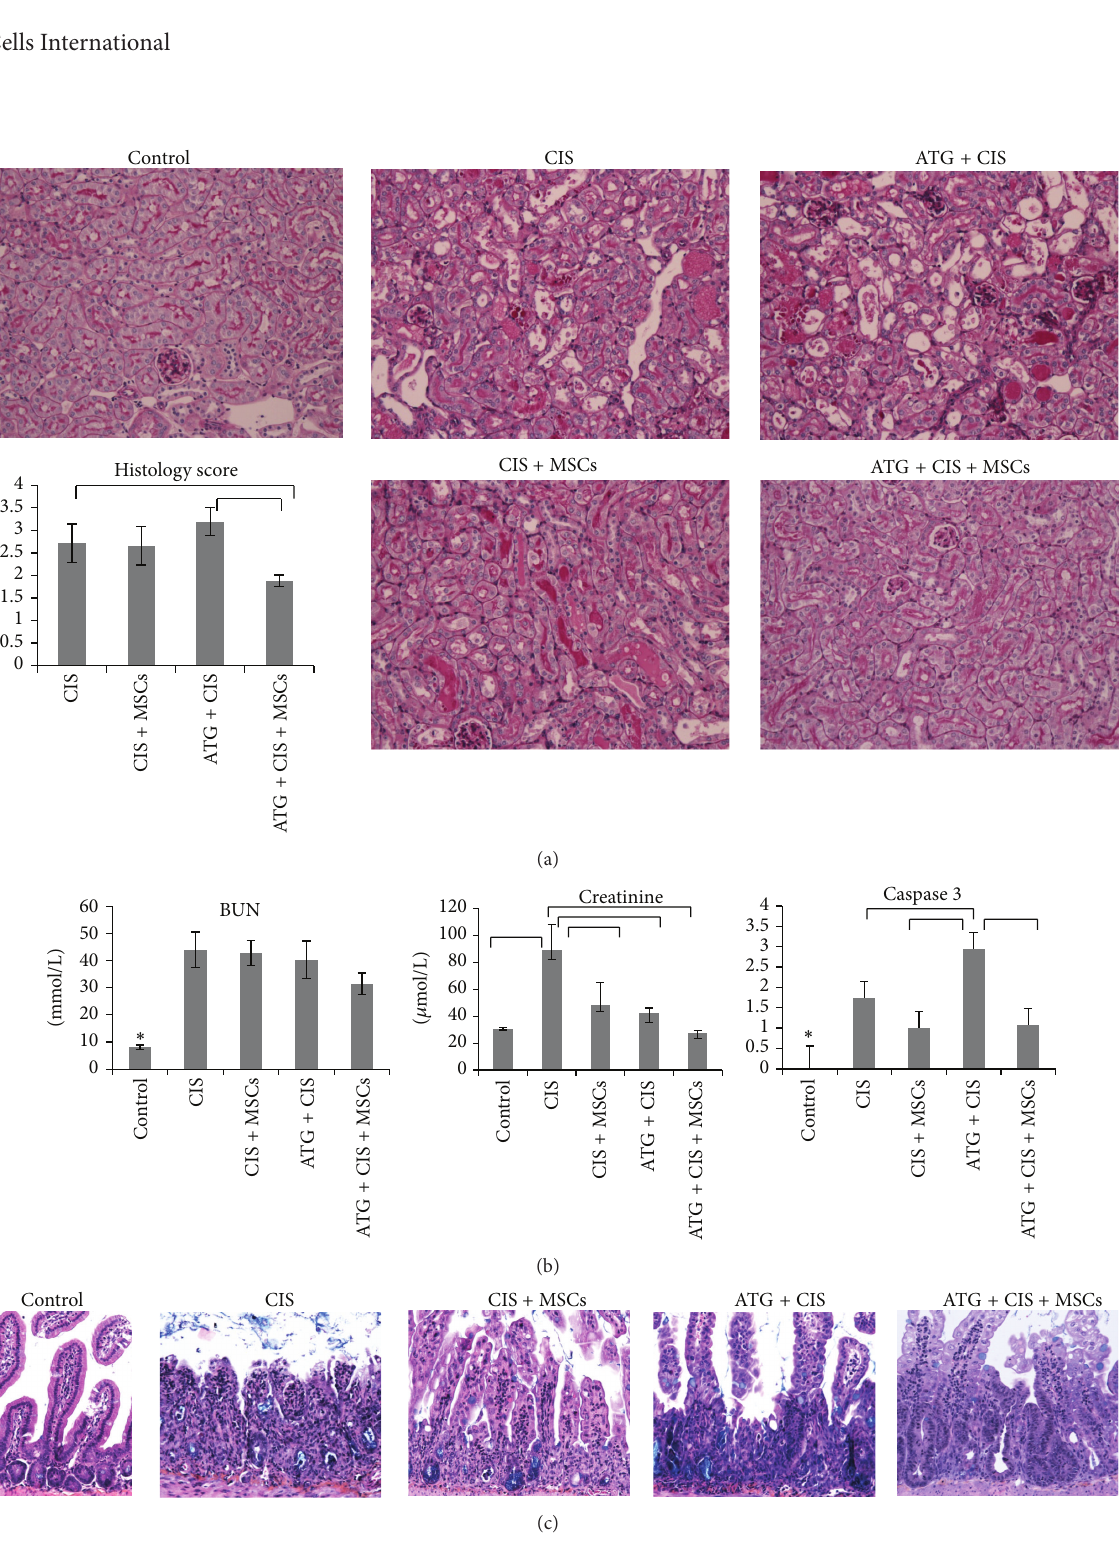
Figure 4: MSC treatment after ATG immunosuppression improves renal function and morphology as well as intestine morphology in BALB/cOlaHsd mice 4 days after cisplatin administration. (a) Representative micrographs of renal histology of healthy control mice and of mice treated with cisplatin and saline or MSCs and/or ATG (original magnification: × 200, periodic acid-Schiff (PAS) staining). (b) Serum concentration of blood urea nitrogen (BUN) and creatinine and caspase 3 score. Graphical results are expressed as mean ± SEM; ANOVA followed by Duncun multicomparison test: ∗ 𝑝 < 0.05 control versus all other groups. (c) Representative micrographs of intestine of healthy control mice and of mice treated with cisplatin and saline or MSCs and/or ATG (original magnification: × 200, Kreyberg-Jareg